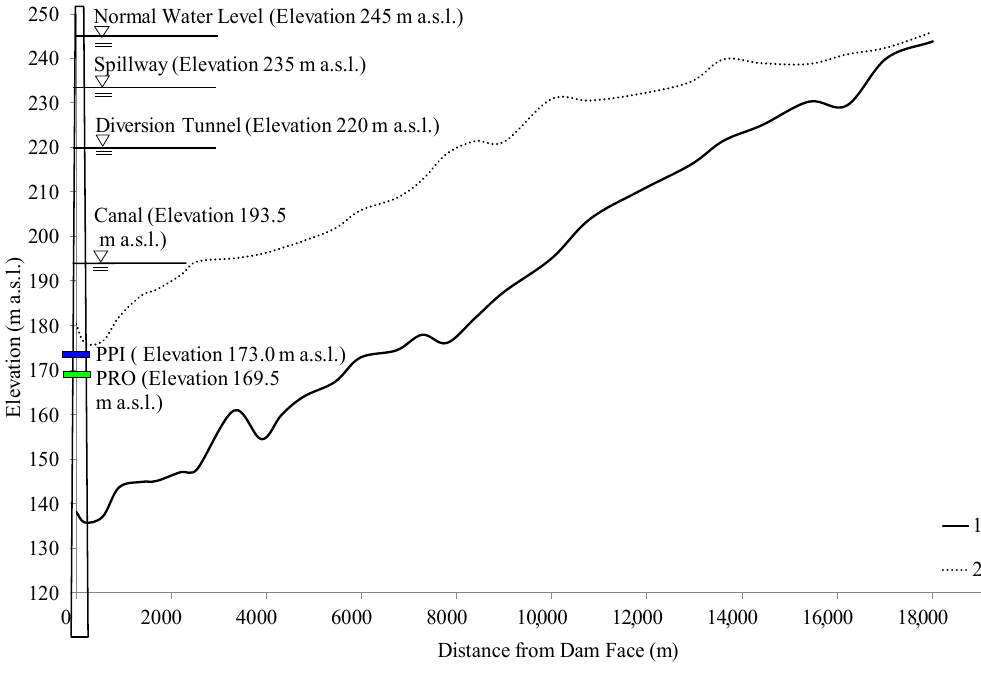
Figure 3. Longitudinal elevation of Shimen Reservoir.